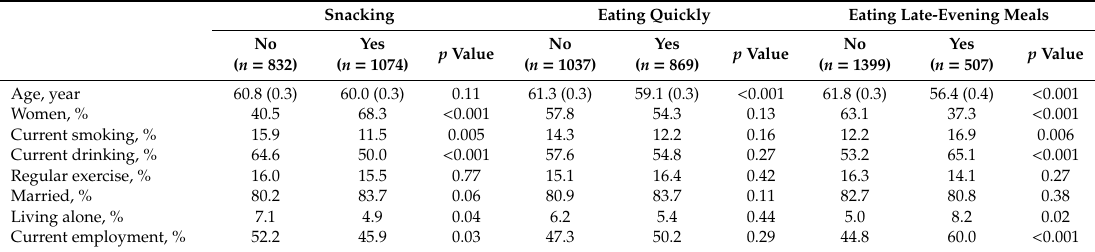
Table 1. Age- and sex-adjusted participant characteristics according to the status of each unhealthy eating